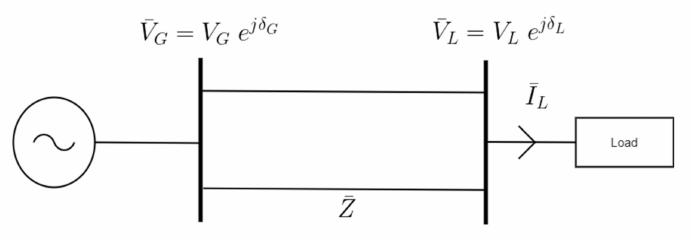
Figure 2. Equivalent two-bus system